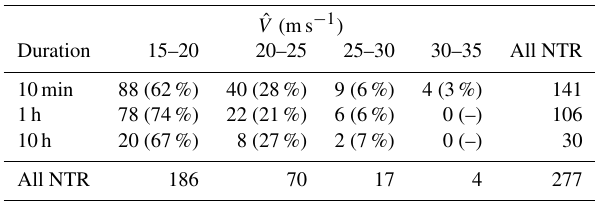
Table 3. Classes of membership of the peak wind speed of the thun- derstorm